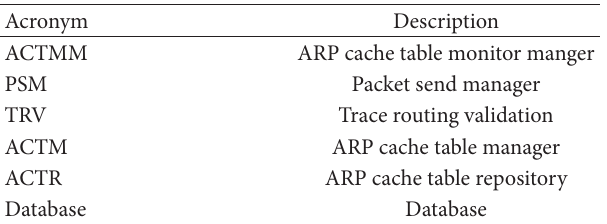
Table 1: Description of